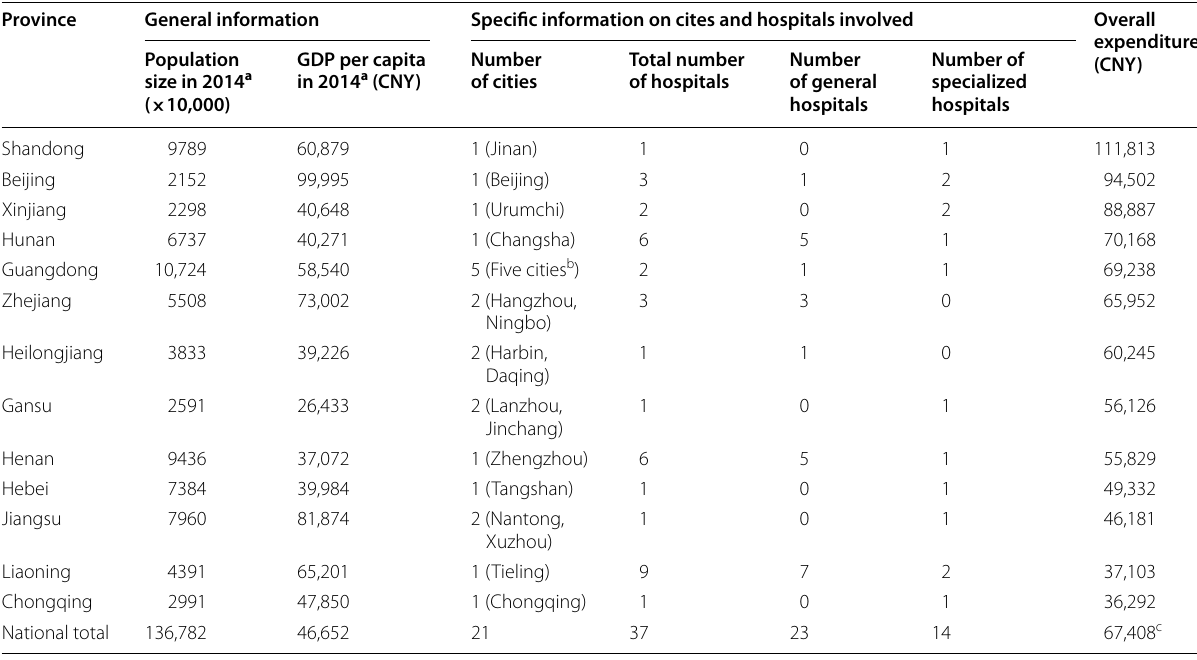
Table 1 Summary information and overall expenditure for diagnosis and treatment of patients with colorectal cancer in 13 study sites in